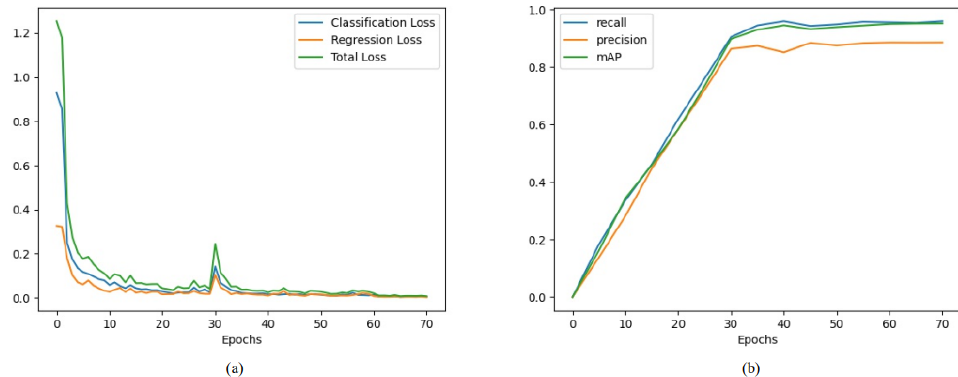
Figure 9. The learning curve on the SSDD dataset. ( a ) The relationship between classification loss, regression loss, total loss and epoch. ( b ) The relationship between the precision, recall, mAP and epoch. Table 7. The confusion matrix of the HRSID dataset in the entire, inshore and offshore scenes. Entire Scenes Inshore Scenes Offshore Scenes